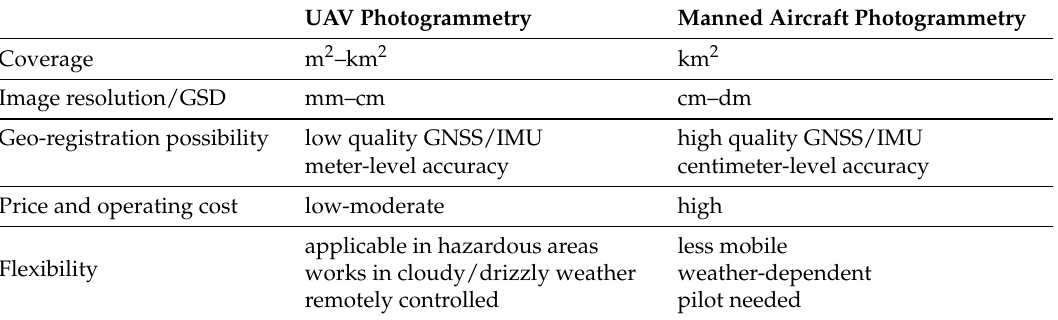
Table 1. Comparison between UAV and manned aircraft photogrammetry.